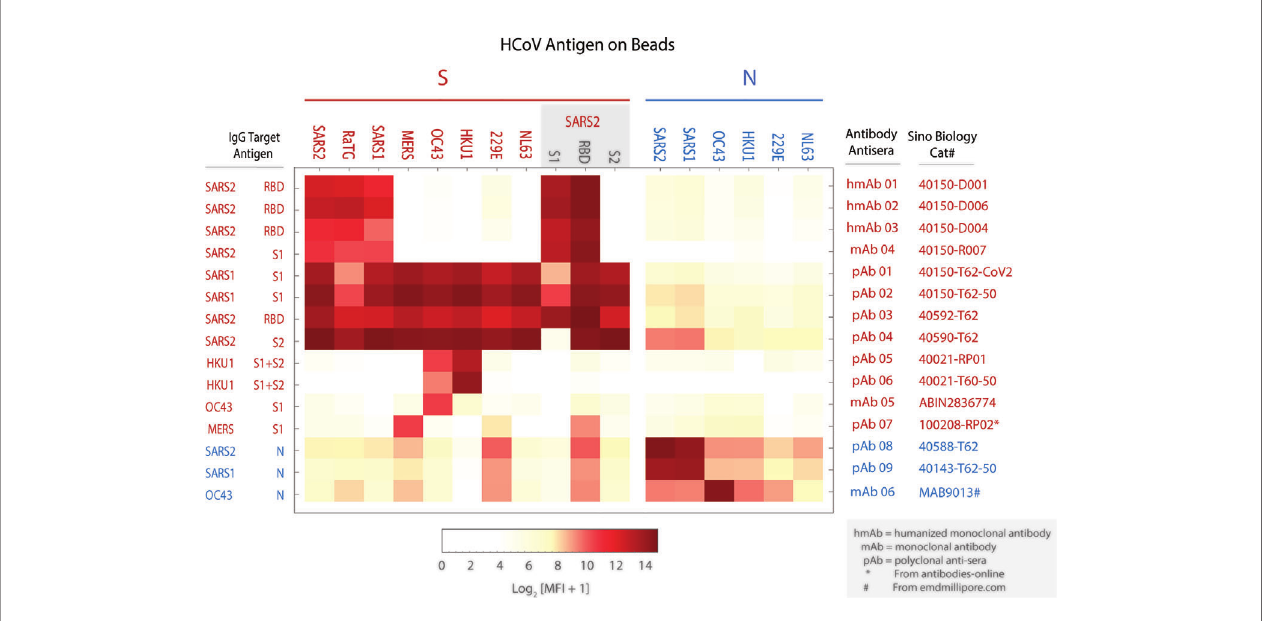
FIGURE 3 | Veri fi cation of mPlex-Cov assay: The binding pro fi le (MFI) of spike (S) and nucleocapsid (N) proteins coupled to Luminex beads reacting with monoclonal and polyclonal antibodies. The antibodies were serially diluted based on the concentrations recommended by manufacture manual. The heatmap displays the average median fl orescence intensity (MFI) of duplicate wells using the representative dilution for each antibody listed. See Methods for speci fi c antibody catalog numbers and